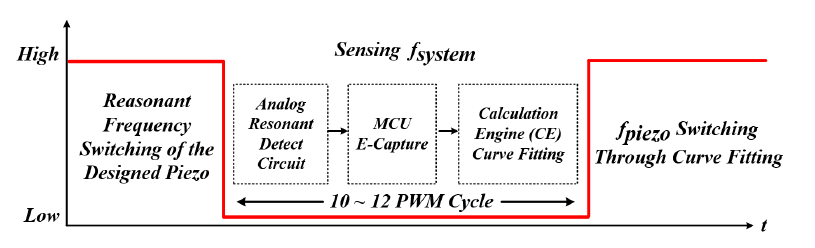
Figure 14. Control